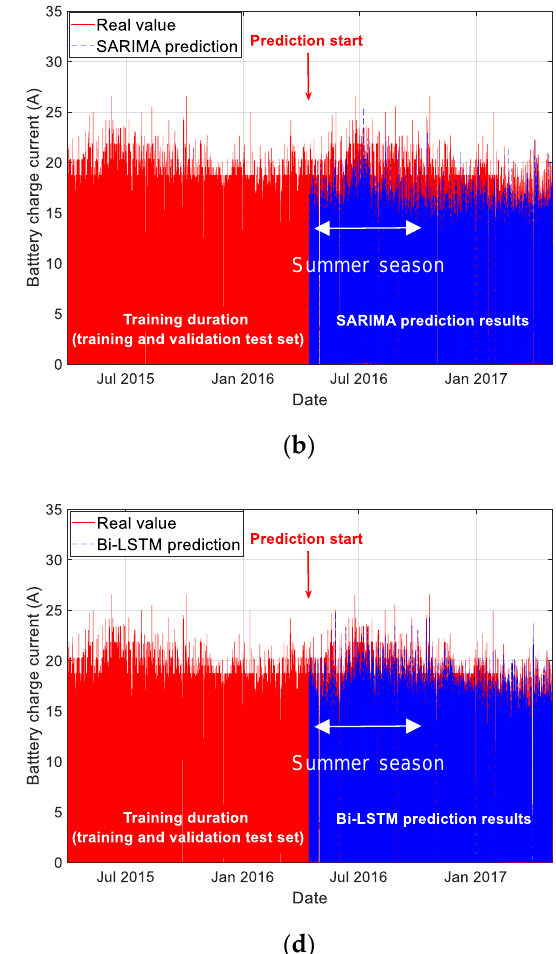
Figure 8. KOMPSAT-3A battery charge and discharge current prediction results: ( a ) SARIMA results for discharge current; ( b ) SARIMA results for charge current; ( c ) Bi-LSTM results for discharge current; ( d ) Bi-LSTM results for charge current.